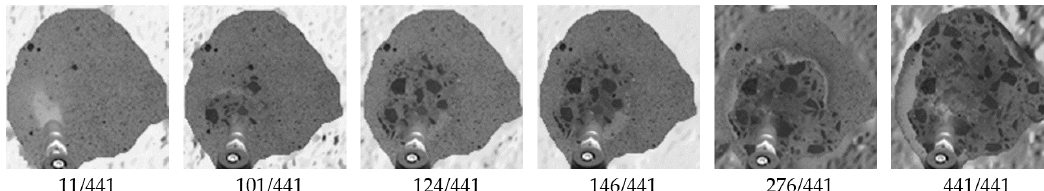
Figure 15. Evolution of crack width for the specimen with a size of 300 × 300 mm.